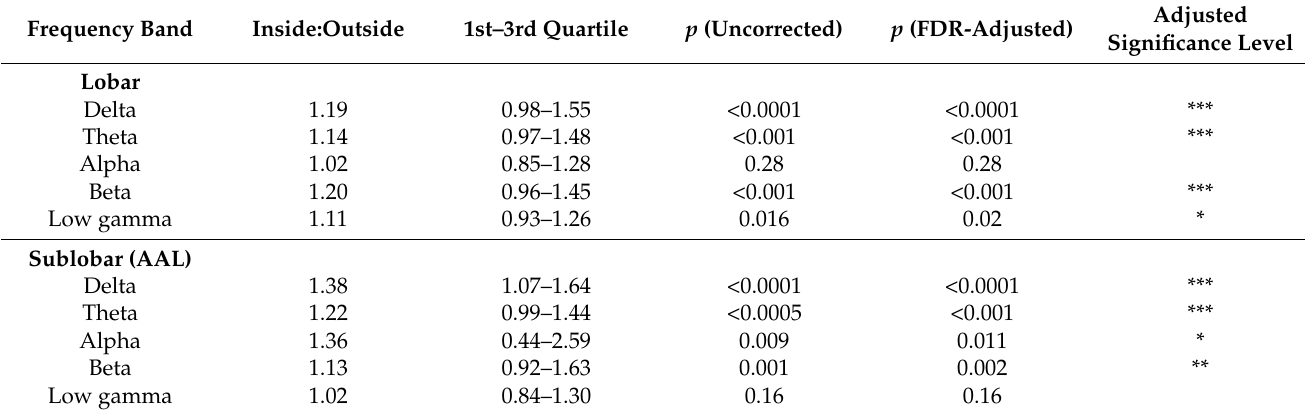
Table 2. Ratio of node degree values inside vs. outside the iEEG SOZ. Significance levels: * p < 0.05,